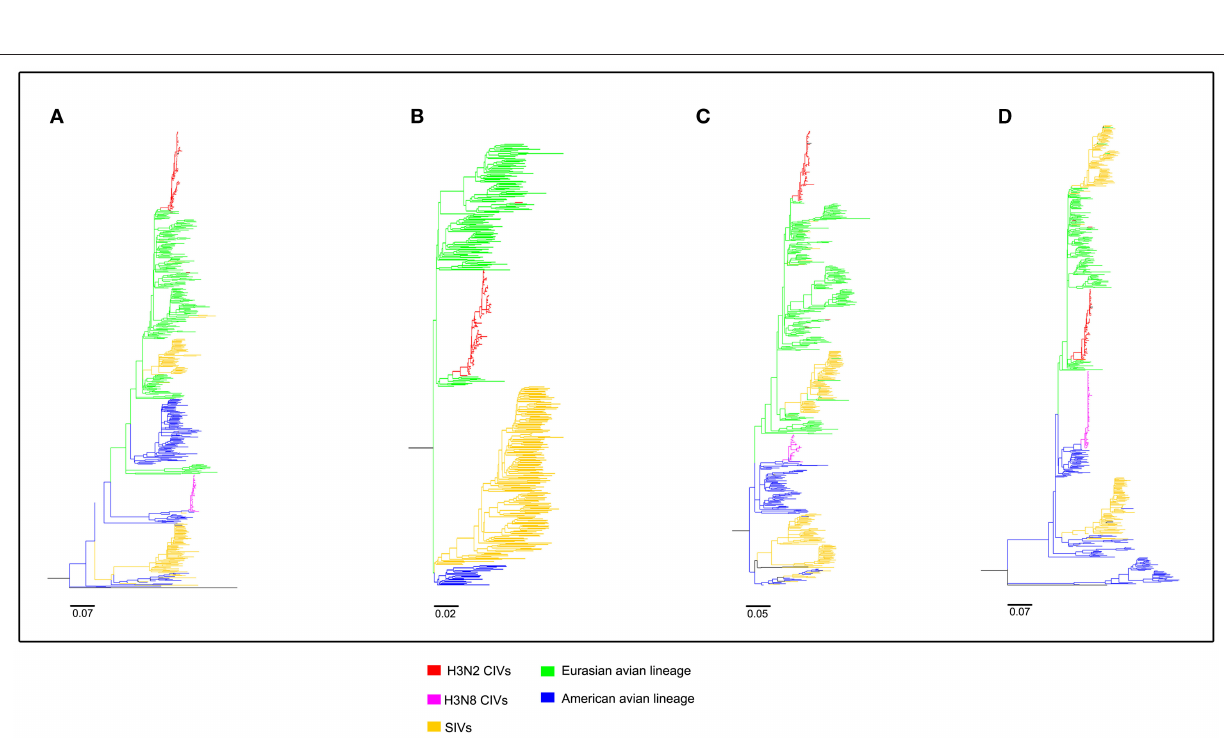
Frontiers in Veterinary Science |